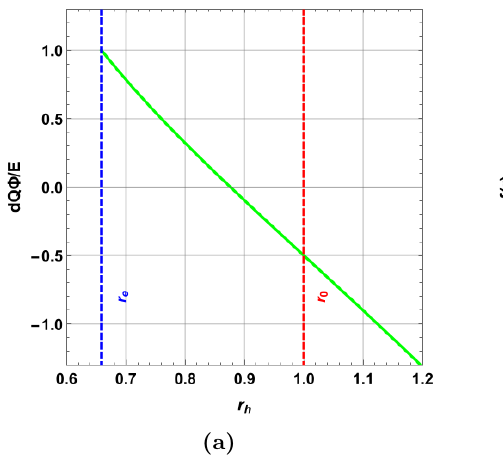
dQ Φ Figure 22. (a) Ratio and (b) f ( r ) function for different masses as a function of event horizon E radius with Q = 1 , l = 1 and D = 4